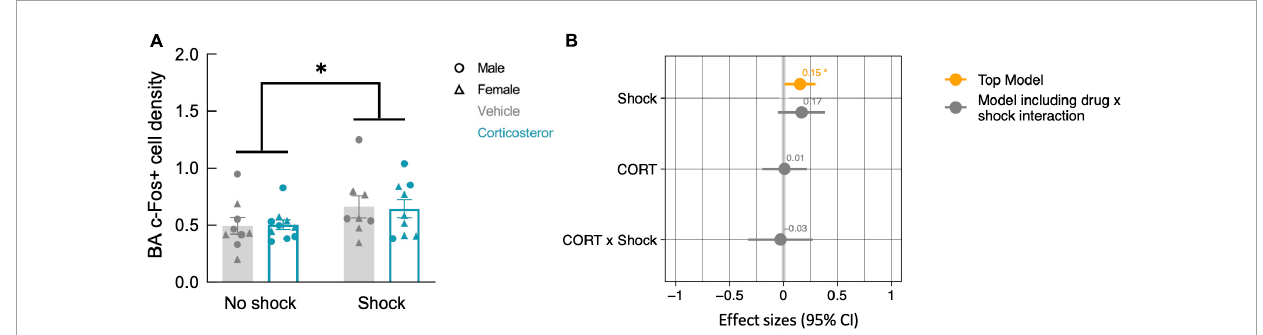
FIGURE7 History of footshock, but not corticosterone treatment, increased neural activity in the basal amygdala during context re-exposure. (A) The density of c-Fos+ cells was greater in animals previously exposed to footshocks than in control animals. (B) The top linear regression model included only history of footshock as a predictor, with a significant positive effect size. The model including an interaction term between corticosterone treatment and shock was a worse fit and included no meaningful effect of the interaction or of each independent predictor. ∗ P < 0.05.